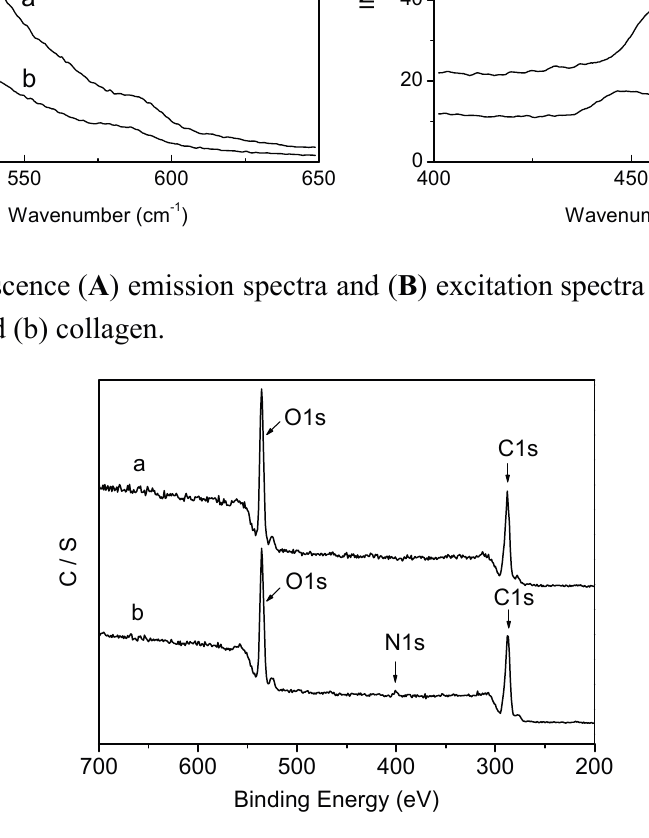
Figure 3. XPS spectra of (a) PLA and (b)